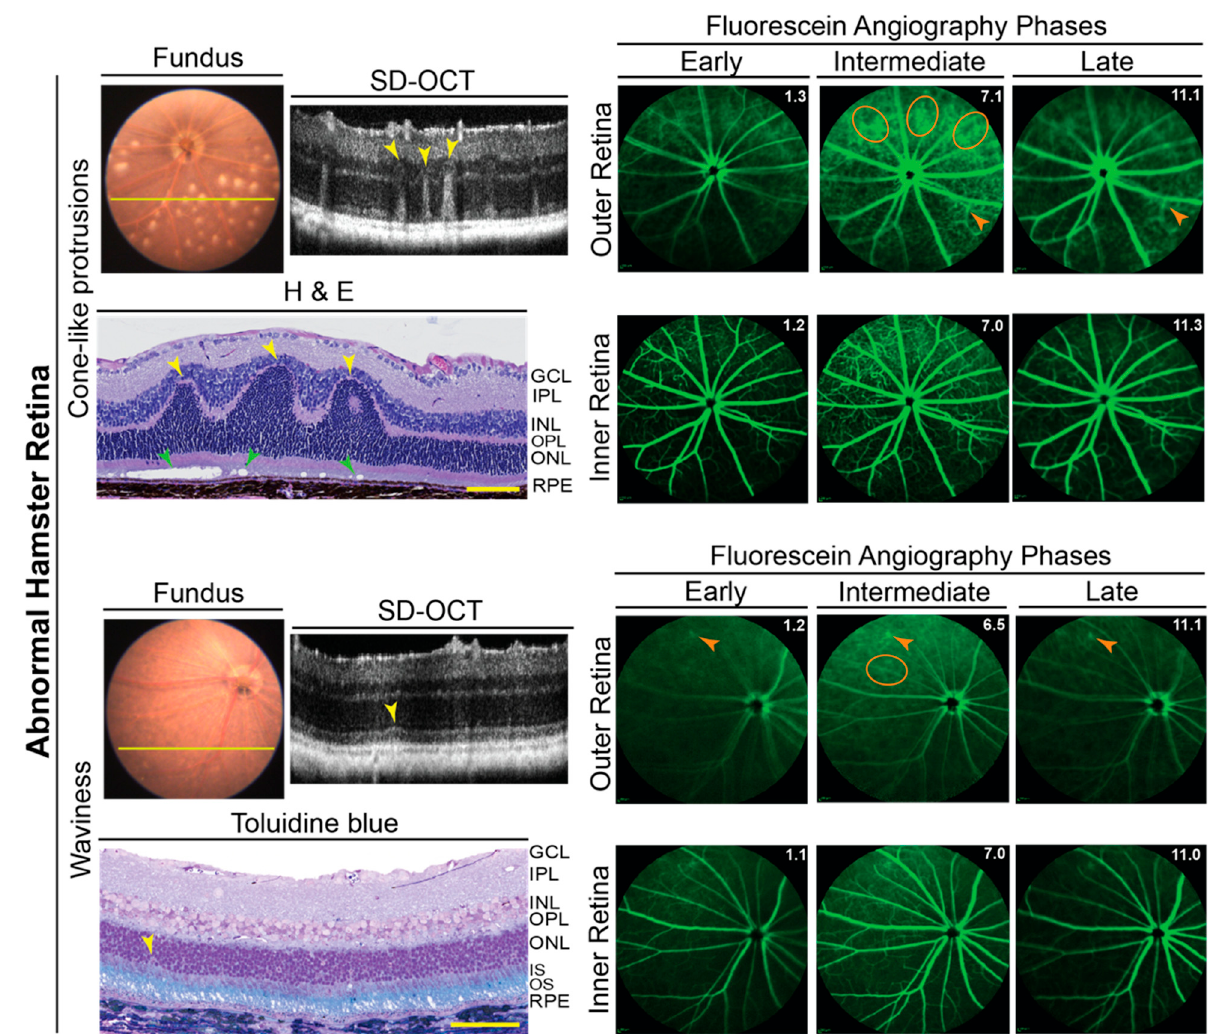
Figure 4. Abnormalities in hamster retina as assessed by in vivo imaging and histology. Representative images (two females and one male for cone-like protrusions; one female and three males for retinal waviness) are of fundus, retinal SD-OCT, fundus fluorescein angiography after an injection with sodium fluorescein, and histology with H&E and toluidine blue stains. For each pathology type (cone-like protrusions and retinal waviness), the same hamster was used for acquisition of all images. Yellow lines on fundus photos indicate location of abnormality seen on SD-OCT. Yellow arrowheads indicate structural abnormalities detected by both SD-OCT and histology. Green arrowheads indicate the degeneration of the photoreceptor outer segments revealed only by histology. Orange ovals and arrowheads indicate diffused margins of some of the retinal capillaries and bright fluorescent spots, respectively, on fluorescein angiography. For fluorescein angiography imaging, the laser beam was focused on either the outer retina or inner retina, which are nourished by the choroidal and intraretinal vascular networks, respectively. White numbers in the upper right corner of each fluorescein angiography panel indicate the post-injection time (in minutes) of image acquisition. The retinal layer labeling is as described in Figures 1 and 2. Scale bars = 100 µm.